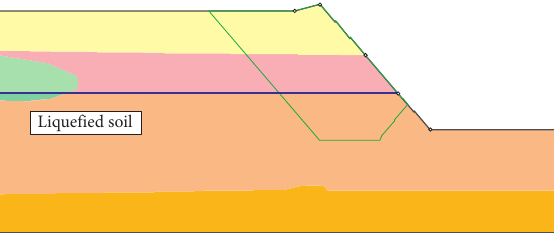
Figure 17: Postliquefaction yield acceleration of Wufeng